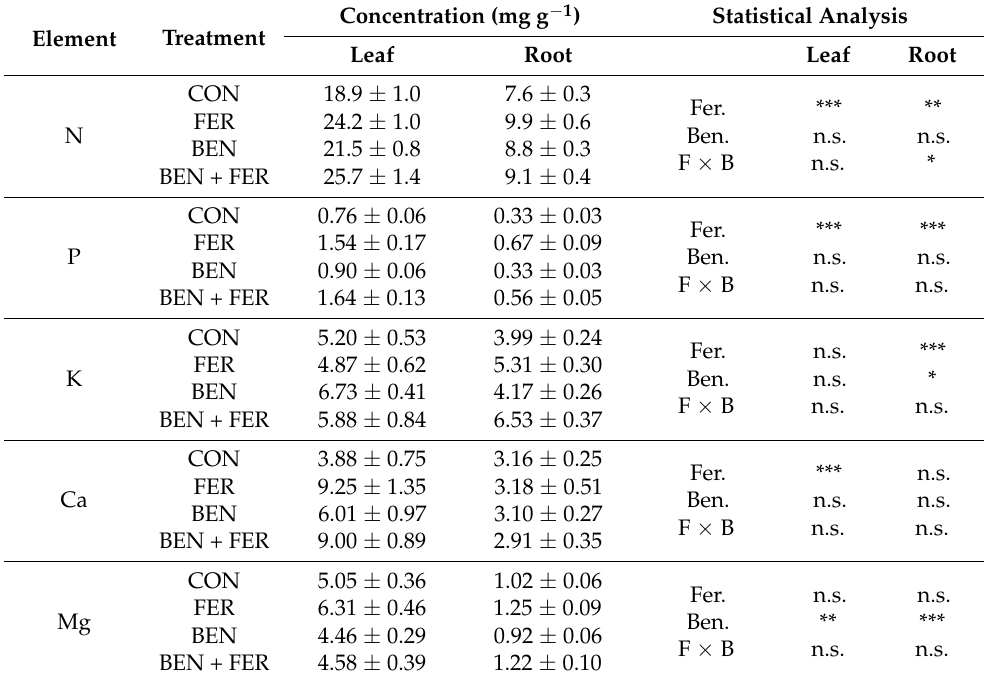
Table 5. Concentrations of elements (N, P, K, Ca and Mg; dry mass) in leaves and roots of